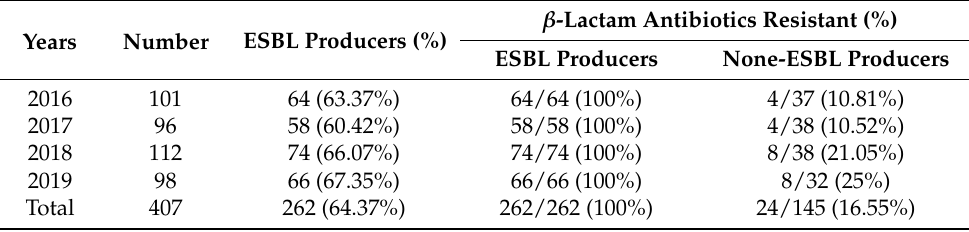
Table 2. Antimicrobial susceptibility and phenotypic identification.